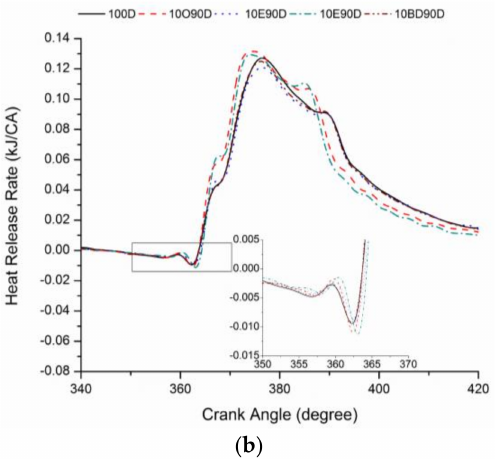
Figure 9. Heat Release Rate variations of tested fuel blends @ ( a ) 50% and ( b ) 100%